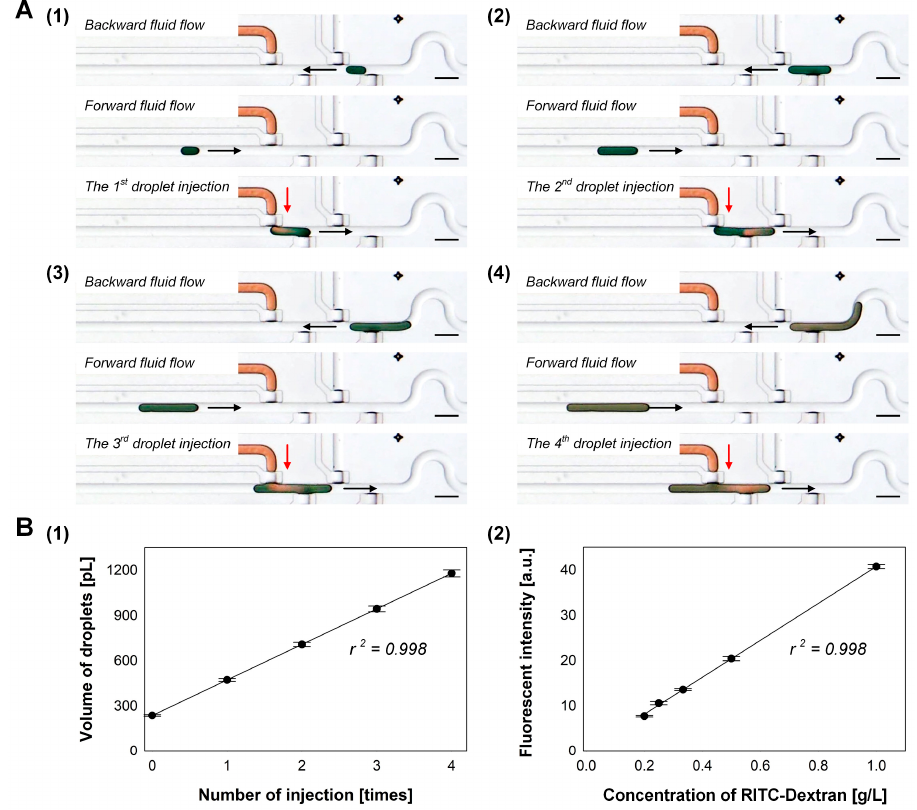
Figure 4. Serial injection of droplets into the target droplet in the droplet generator; ( A ) Process flow of the serial injection by changing the flow direction of the carrier fluid. Scale bars: 500 µ m; ( B ) sequential dilution of RITC-dextran droplet (initial concentration of 1 g / L) by adding multiple Milli-Q water droplets (n =